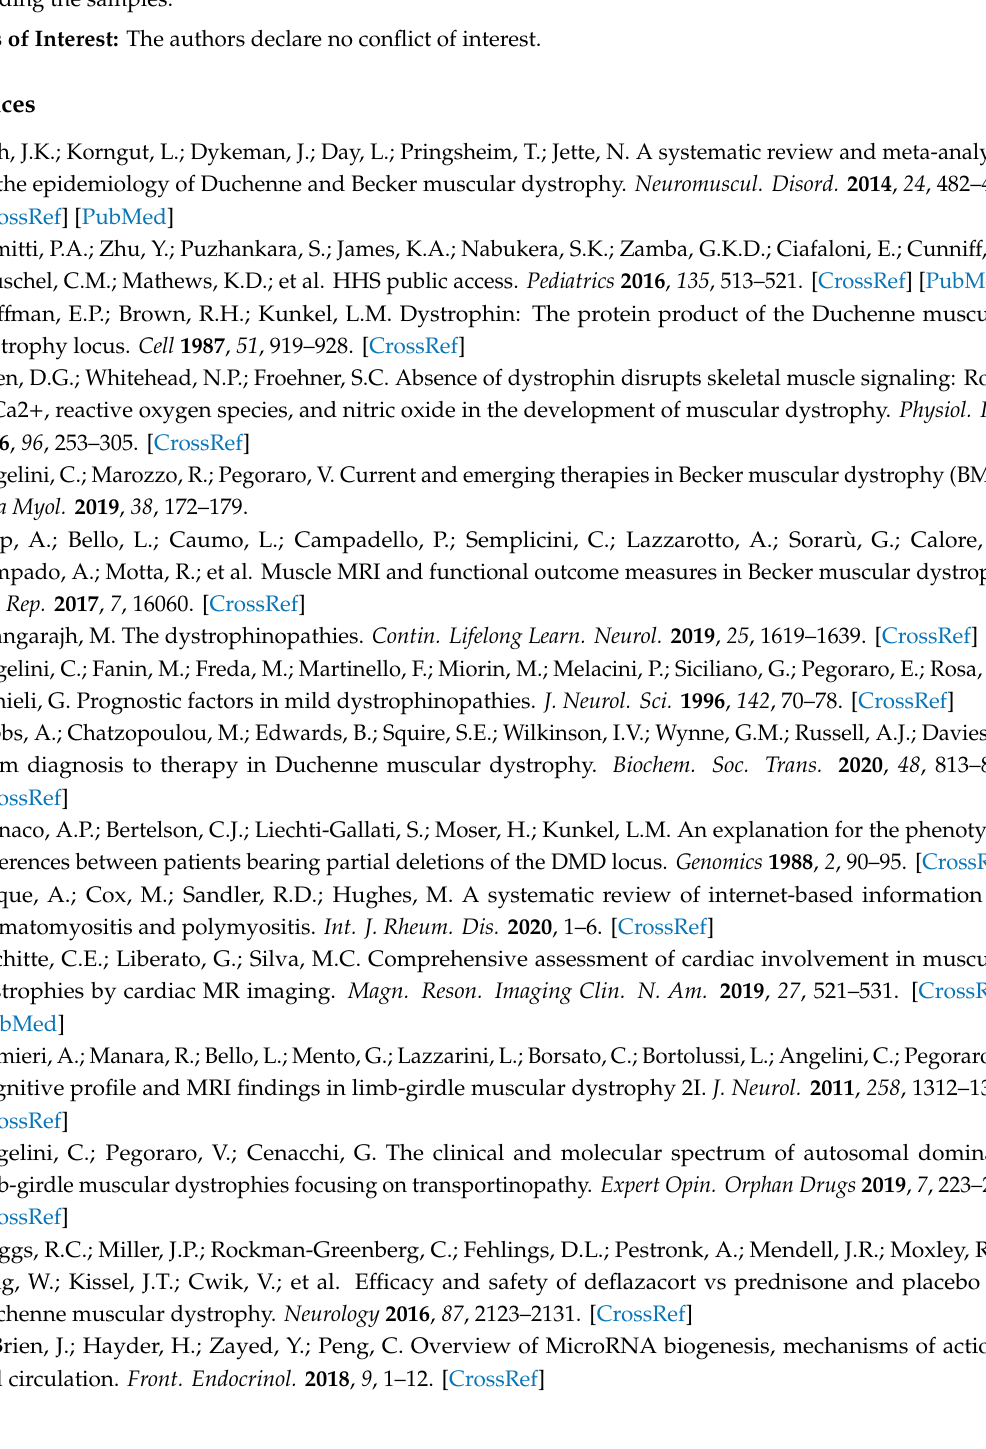
Table S1: TaqMan microRNA primer sequences. Table S2: Fatty infiltration with Mercuri score in lower limb muscles. Figure S1: Myostatin (Myo) and follistatin (Foll) levels in plasma of eight Becker muscular dystrophy (BMD) and six controls. Data were presented as mean + standard